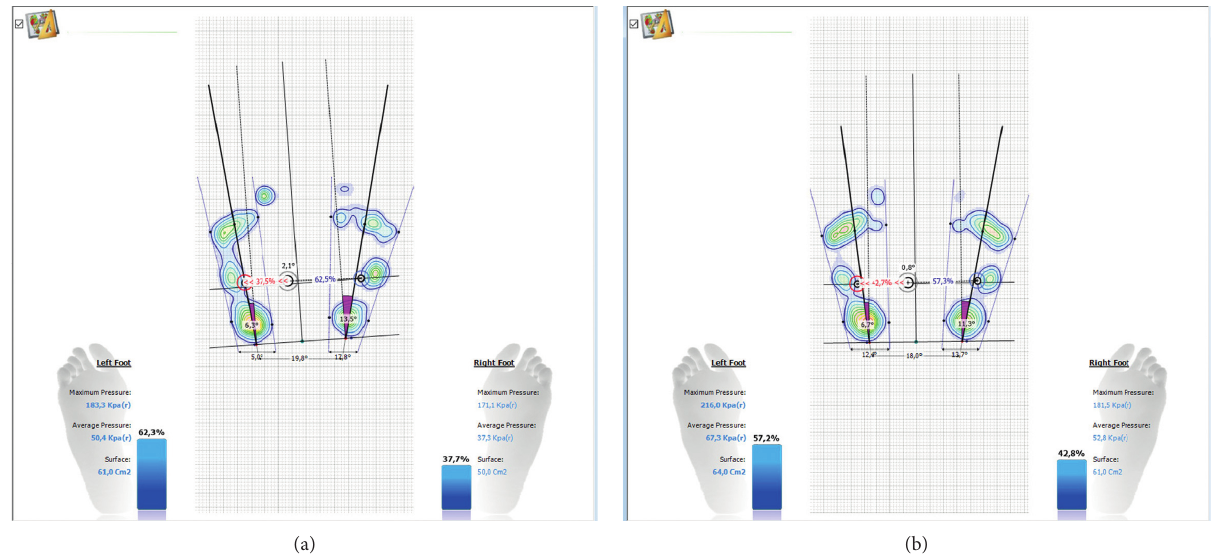
Figure 8: The exemplary result of assessing the mutual relationship between the feet and the proportions of the feet.